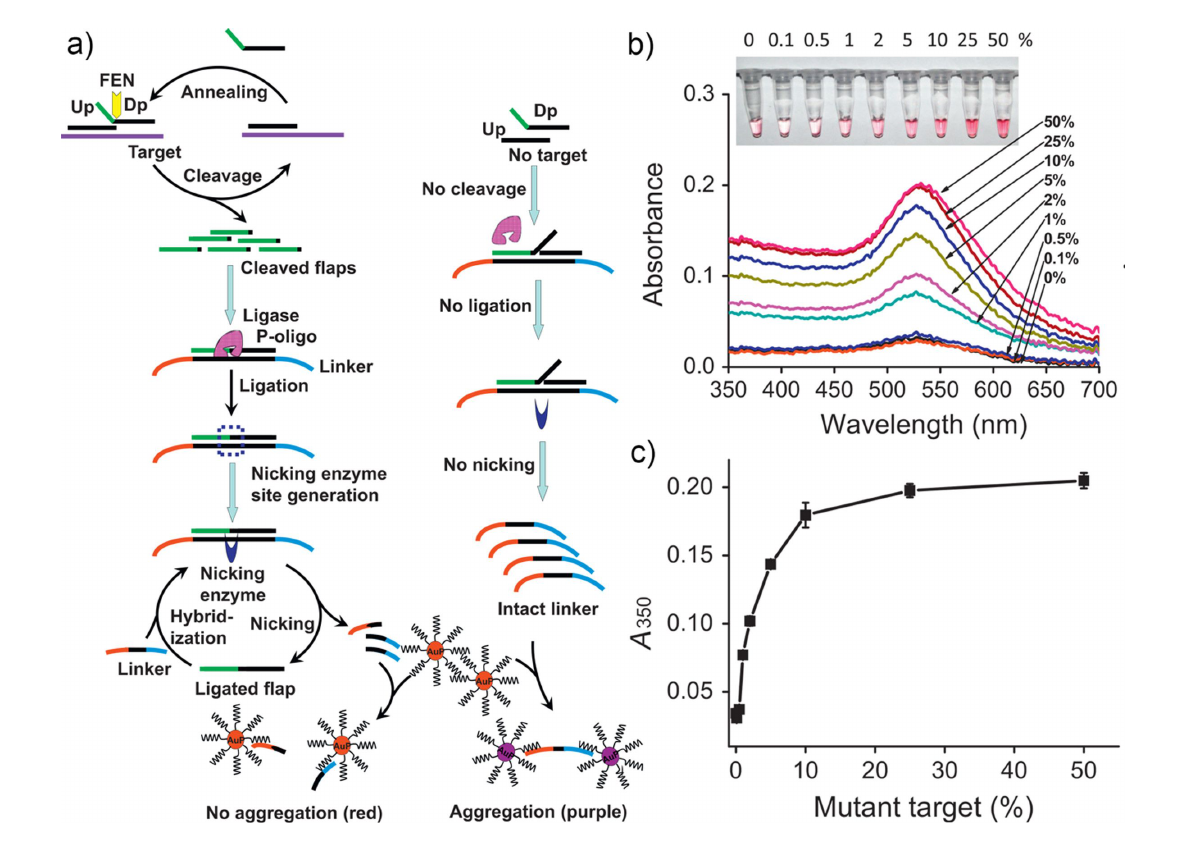
Figure 13: a) The working principle of DNA target detection through an invasive reaction coupled with NEase-assisted nanoparticle amplification. b) Optical characterization of the assay solution spiked with different amounts of c.2573 T>G mutant EGFR gene in the presence of a background wild-type EGFR sequence, showing a specificity down to 1%. c) The relation of increased absorbance with increasing the relative concentration of mutated sequence in assay mixture. Reprinted with permission from [105], copyright 2015